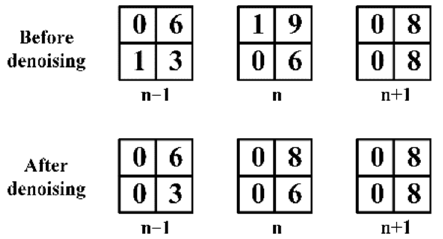
Figure 2. Examples of changes in night-light image raster data for different years before and after denoising (years n − 1, n and n + 1).